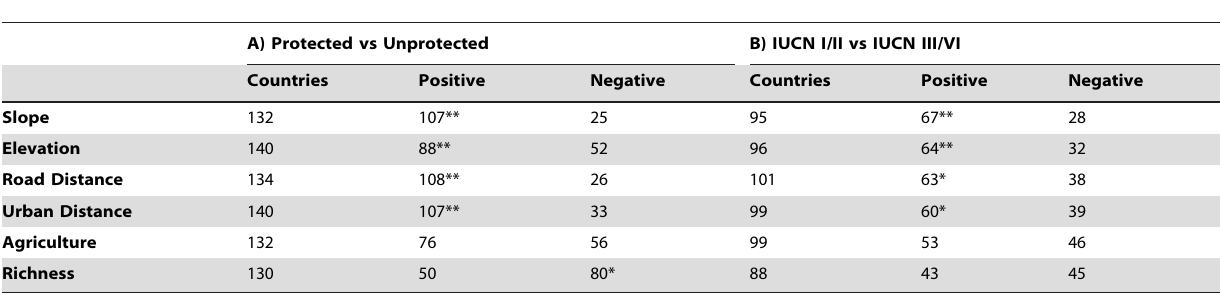
Table 1. Summary statistics for the individual country models.